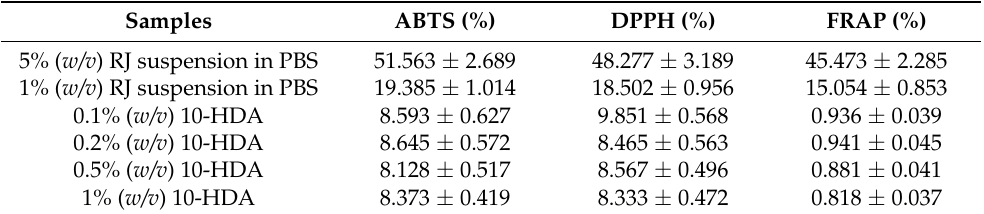
Table 2. Antioxidant activity of RJ and 10-HDA assessed by ABTS, DPPH, and FRAP assays.